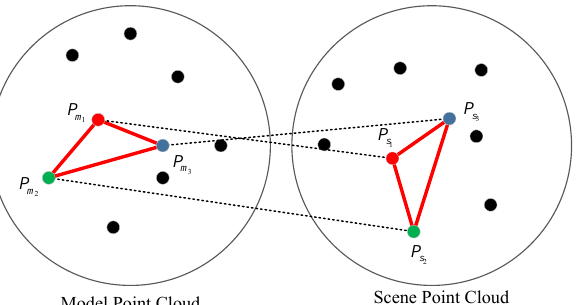
Figure 3. The assumption of geometric constraint, two similar triangles in a model and scene point